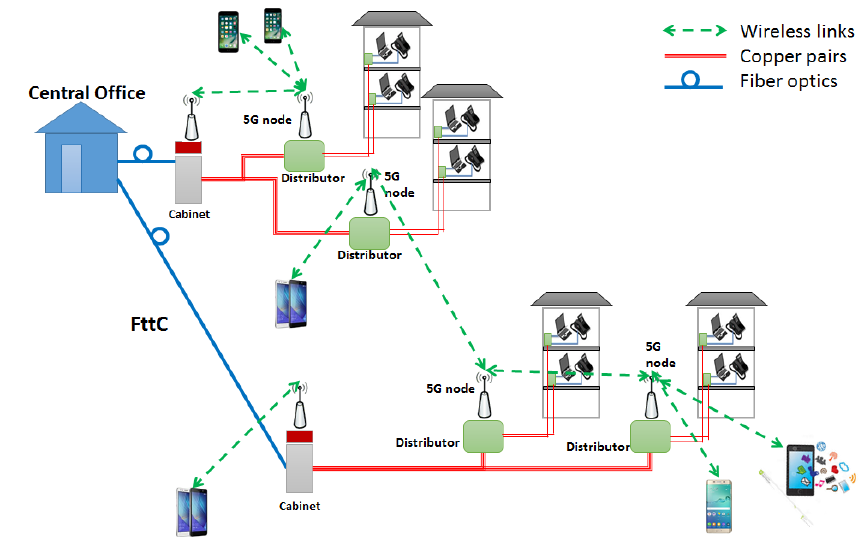
Figure 1. Considered 5G dense network architecture with FttC-based